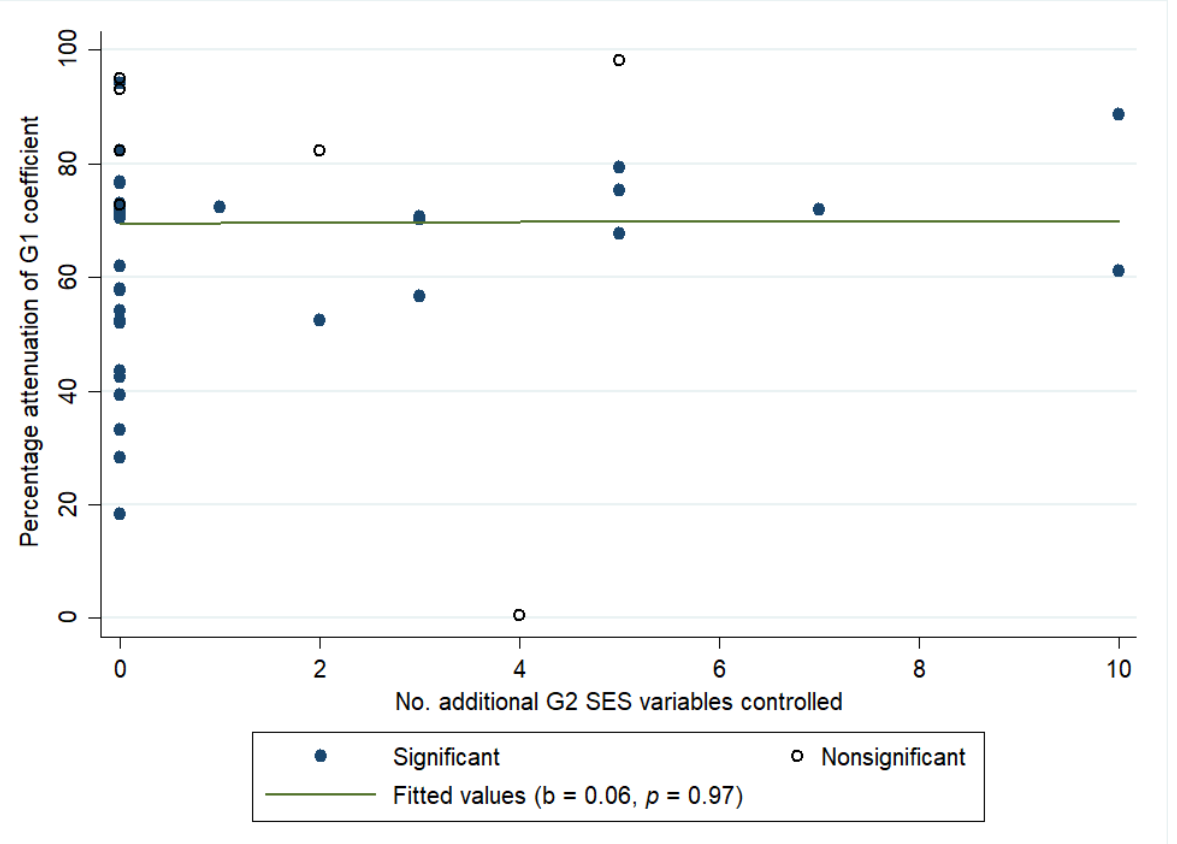
Figure 6: Percentage attenuation in G1 coefficient(s) from bivariate to full model by number of parental SES controls (in addition to parental equivalent of G1 resource) and whether estimates are significant. Note: each point corresponds to an analysis. This figure does not show three analyses in which G1 coefficient attenuation is greater than 100 percent. N =